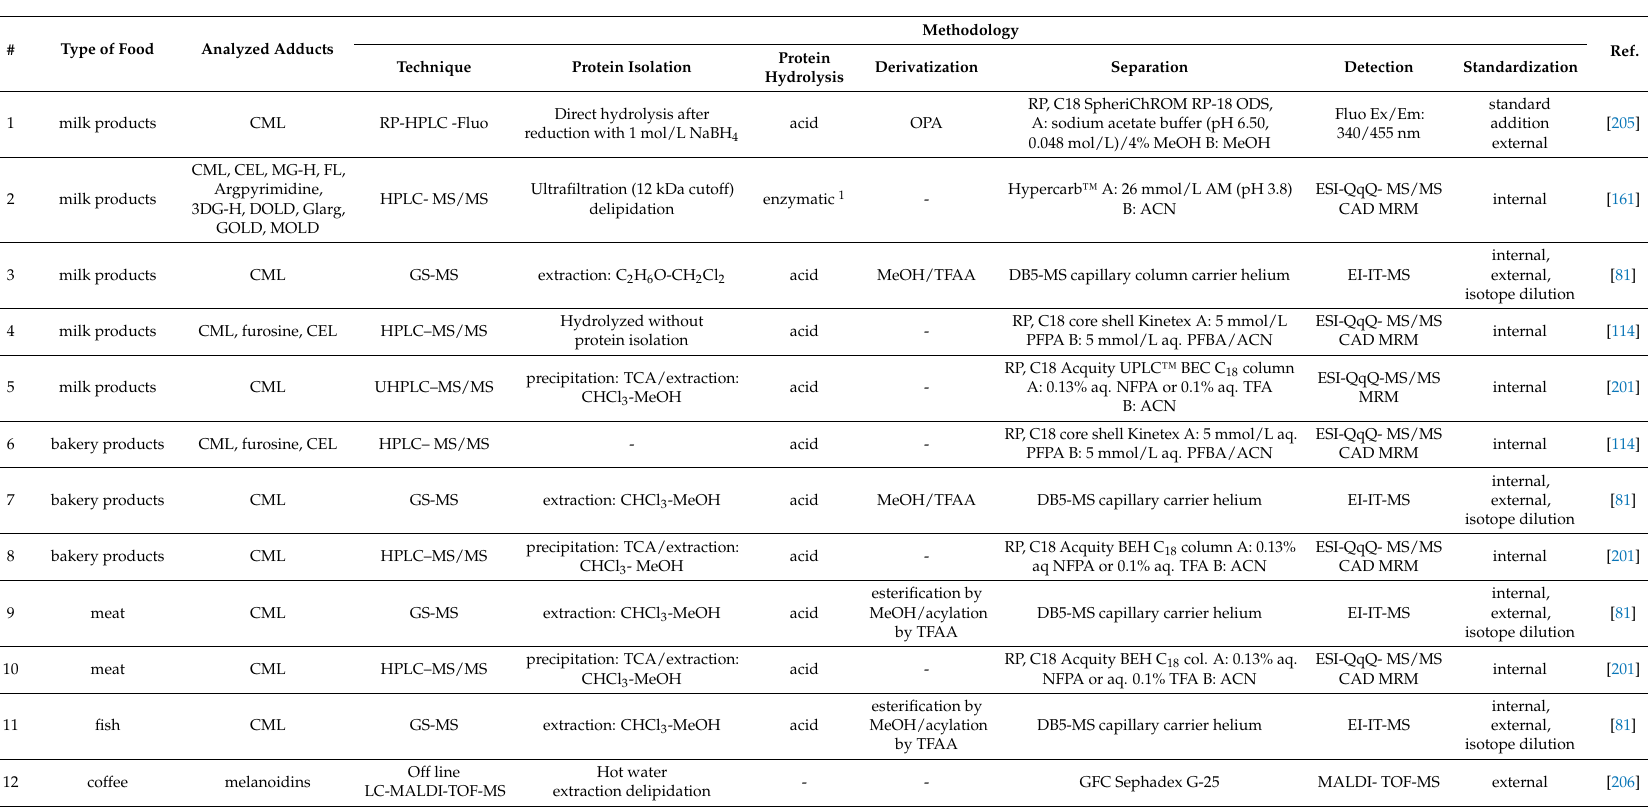
Table 3. Application of glycation adduct analysis in food